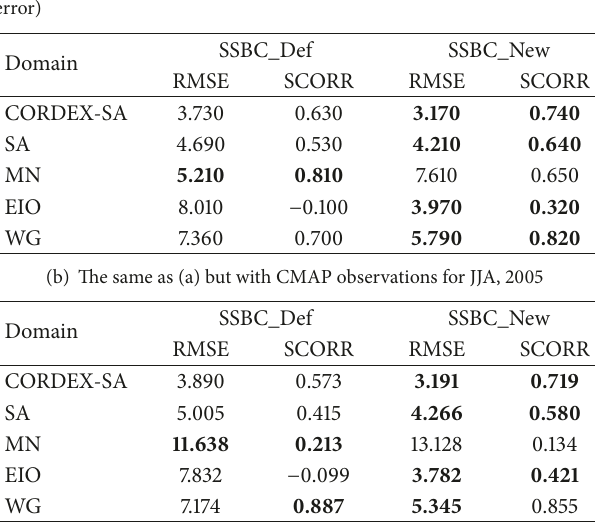
(a) Comparison of the root-mean-square error (RMSE) and spatial correlation (SCORR) of SSBC_Def and SSBC_New, compared